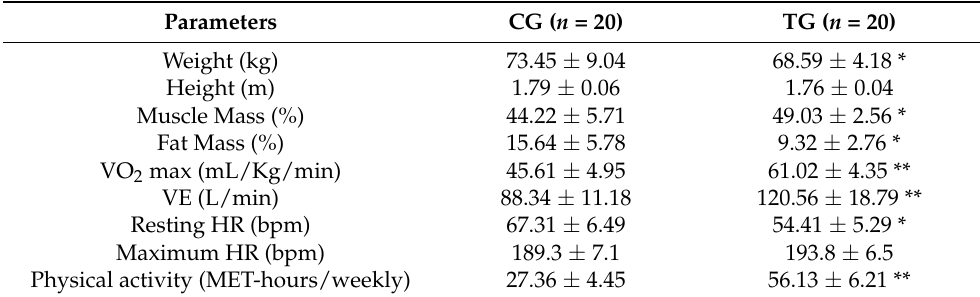
Table 2. Characteristics of the participants.